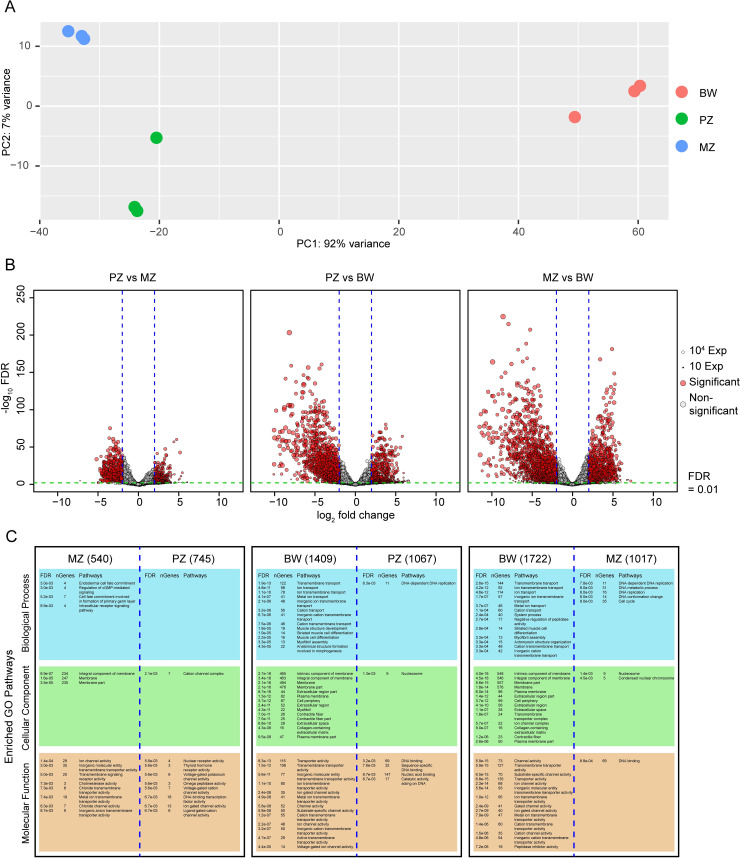
B. malayi gene expression analyses.(A) PCA of the 2000 most variable B. malayi genes in 3 biological replicates for each analyzed tissue, PZ (green); MZ (blue); BW (red). (B) Volcano plots representing differences in gene expression levels between PZ, MZ and BW samples. X axis: log2(fold change); Y axis: -log10 (FDR). Dot size corresponds to gene expression level. Red dots are genes significantly regulated when |log2(fold change)| > 2 and the FDR < 0.01. (C) GO enrichment pathways for each compared tissue for the 3 principal GO categories: biological process (blue); cellular component (green); and molecular function (orange). nGenes: number of genes identified in each category. Numbers in brackets correspond to the number of genes identified as regulated in each tissue for each comparison.